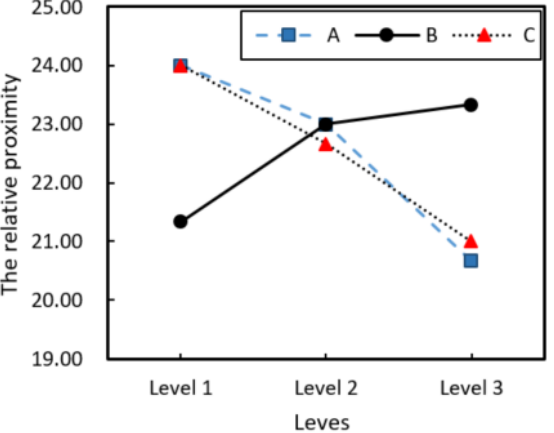
Figure 7. The influence of various factors on relative proximity.